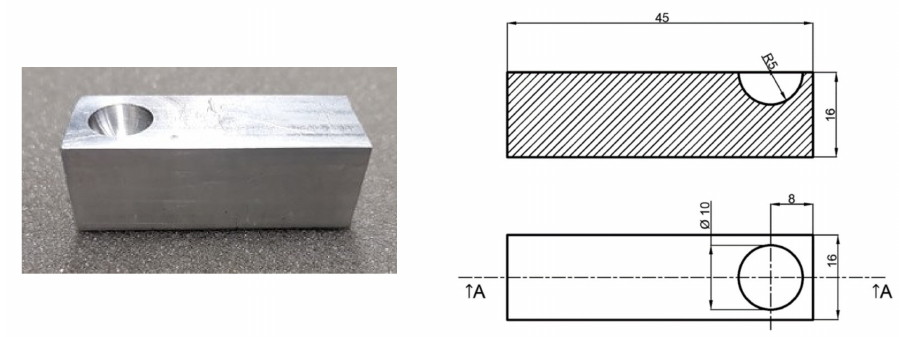
Figure 3. Photograph and dimensions of the reflector used to measure reflected radiation. The presented reflector is mounted in the place of the table with the observed element. Reflector built for the reflected radiation measurement. Dimensions are in